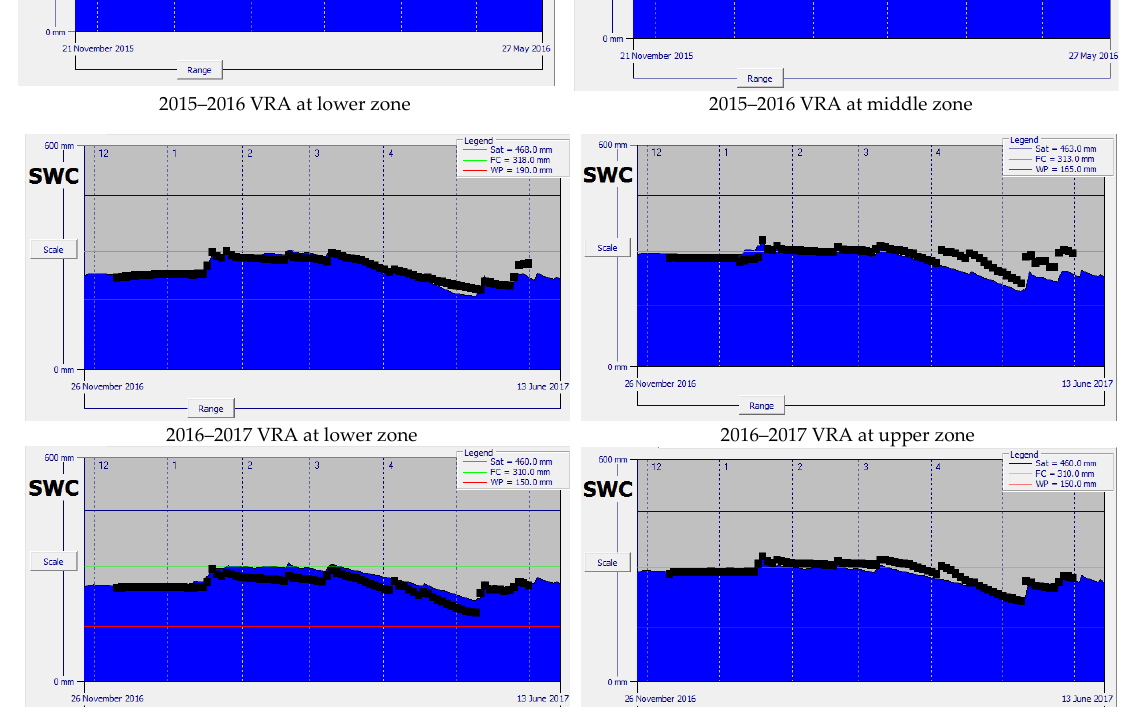
Figure 6. Observed (black line) and simulated (blue area) soil water content of 1 m profile.